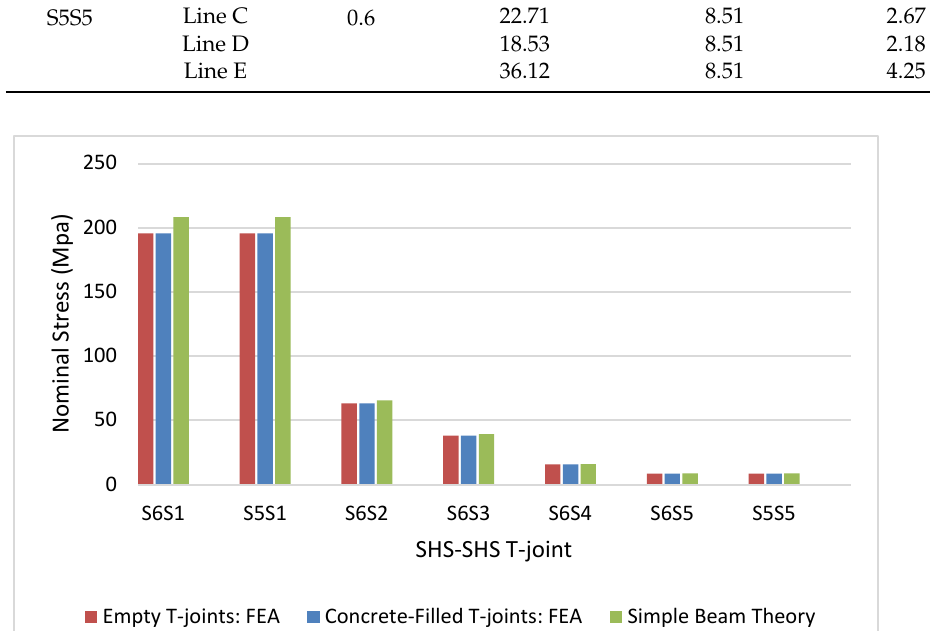
Figure 7. Nominal stresses.